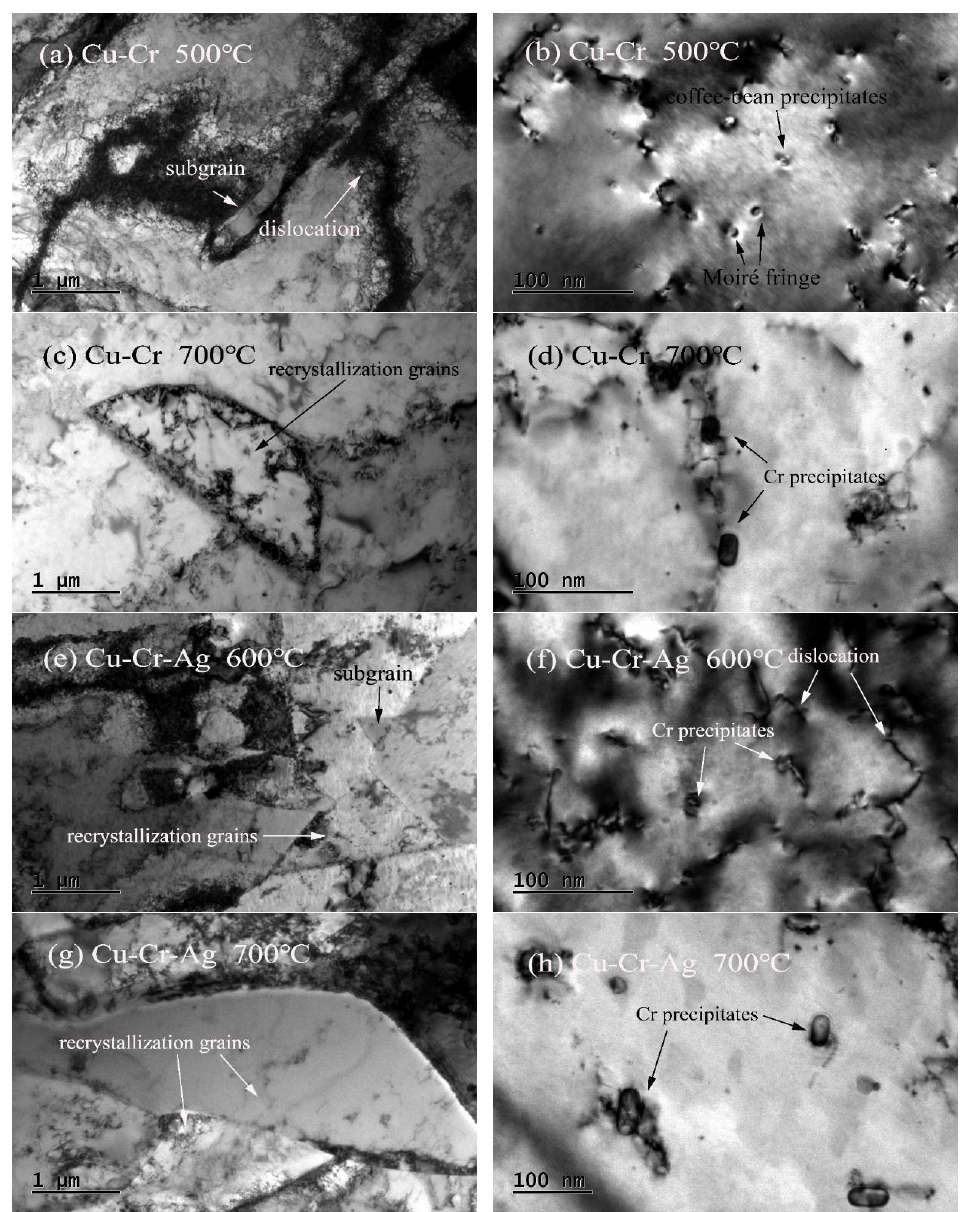
Figure 6. Microstructures of both alloys after holding for 1 h at different annealing temperature levels. Bright ‐ field images of ( a – d ) Cu–Cr and ( e – h ) Cu–Cr–Ag alloys. Bright-field images of ( a – d ) Cu–Cr and ( e – h ) Cu–Cr–Ag